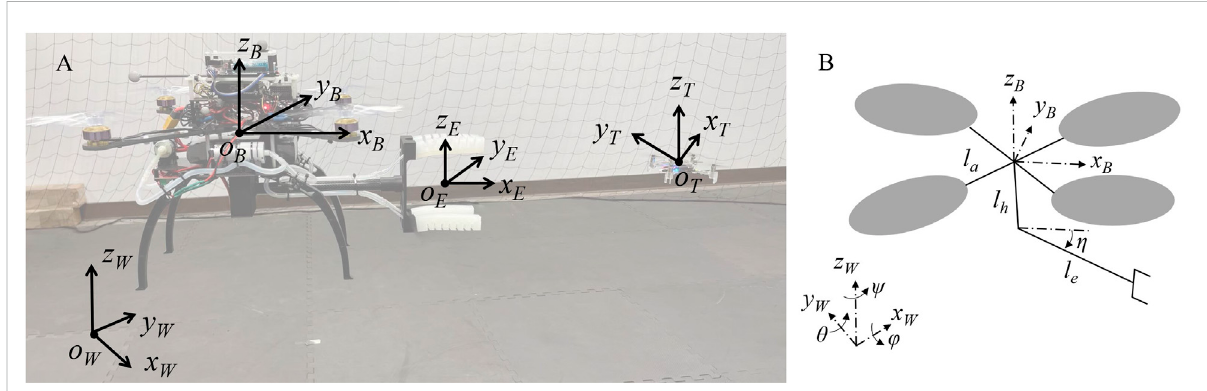
FIGURE 3 Frames and modeling description. (A) Four frames are de fi ned in this work: world, robot, end-effector and target frames. (B) Dynamic model of the